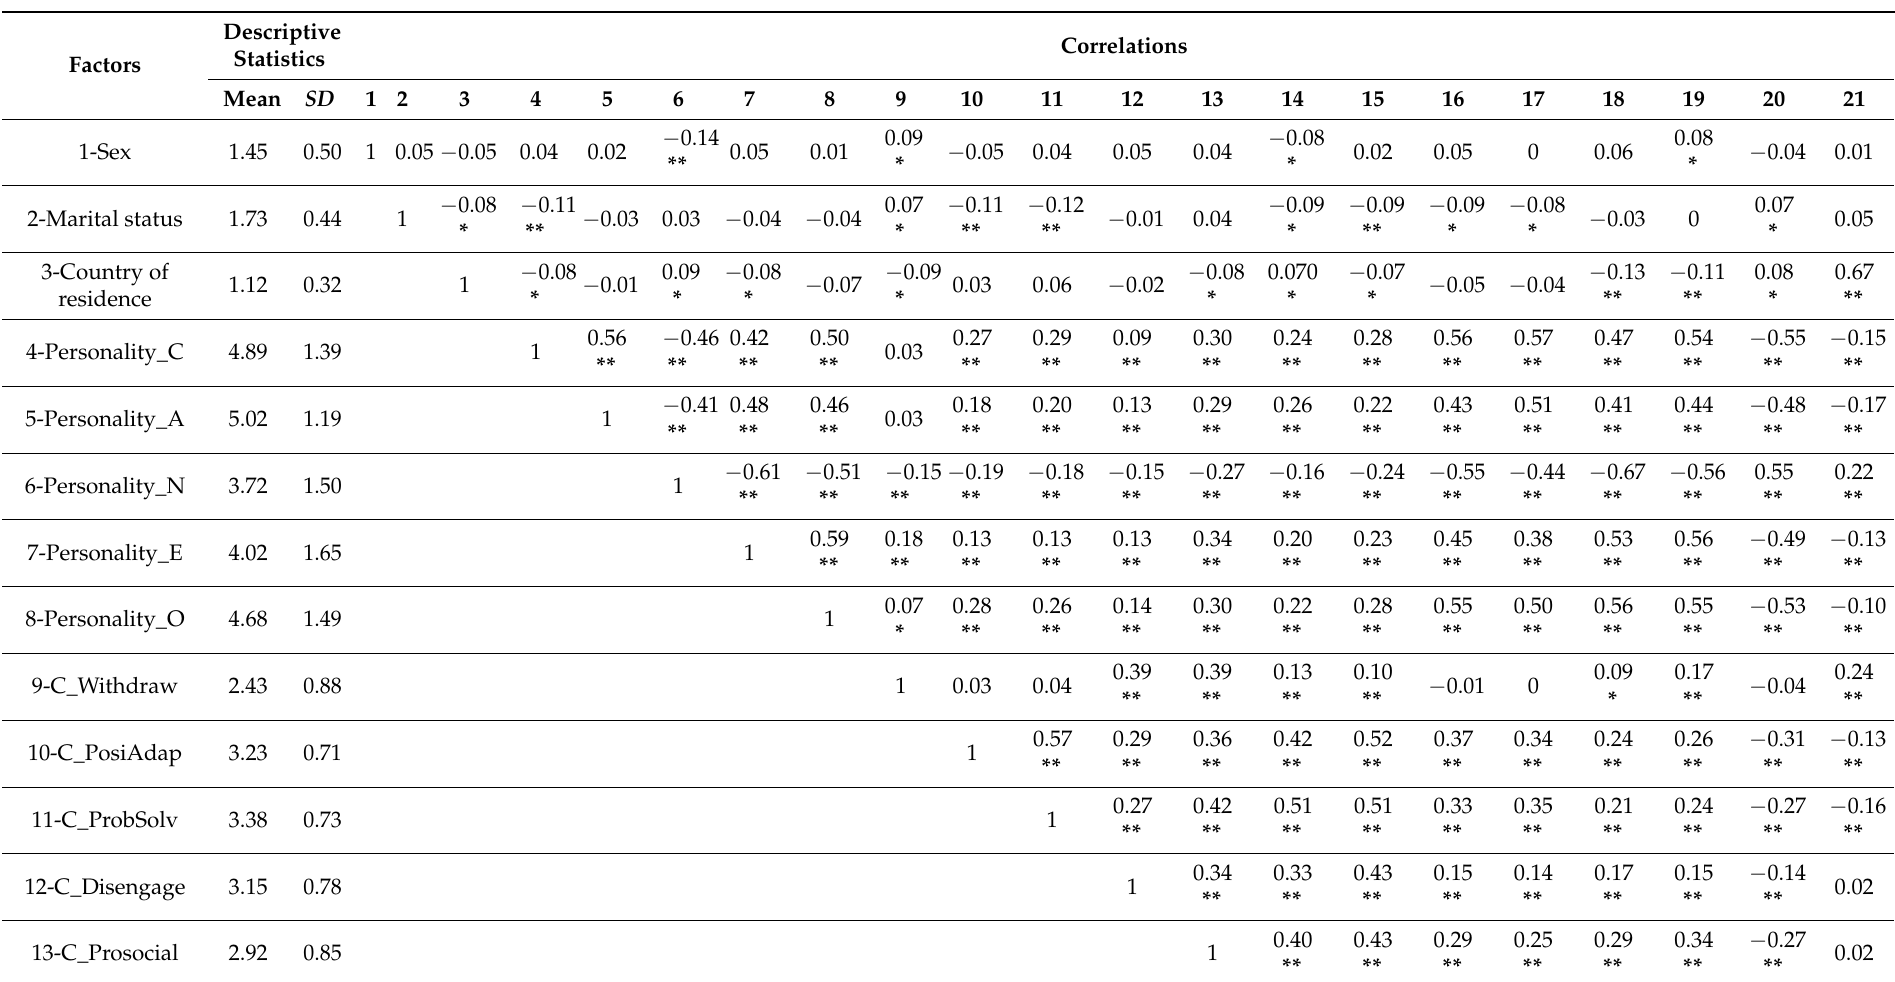
Table 2. Descriptive Statistics and Correlations for All Variables in the MRA ( n =